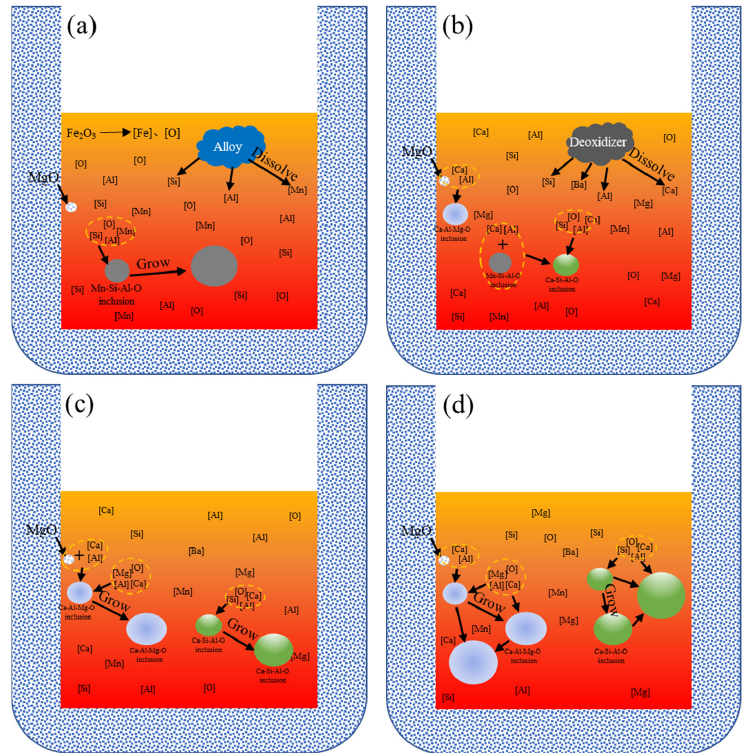
Figure 8. Schematic of inclusion evolution in liquid steel of scheme B. ( a ) steel melting and addition of alloys; ( b ) addition of deoxidizer; ( c ) refining over time; ( d ) refining over more time.